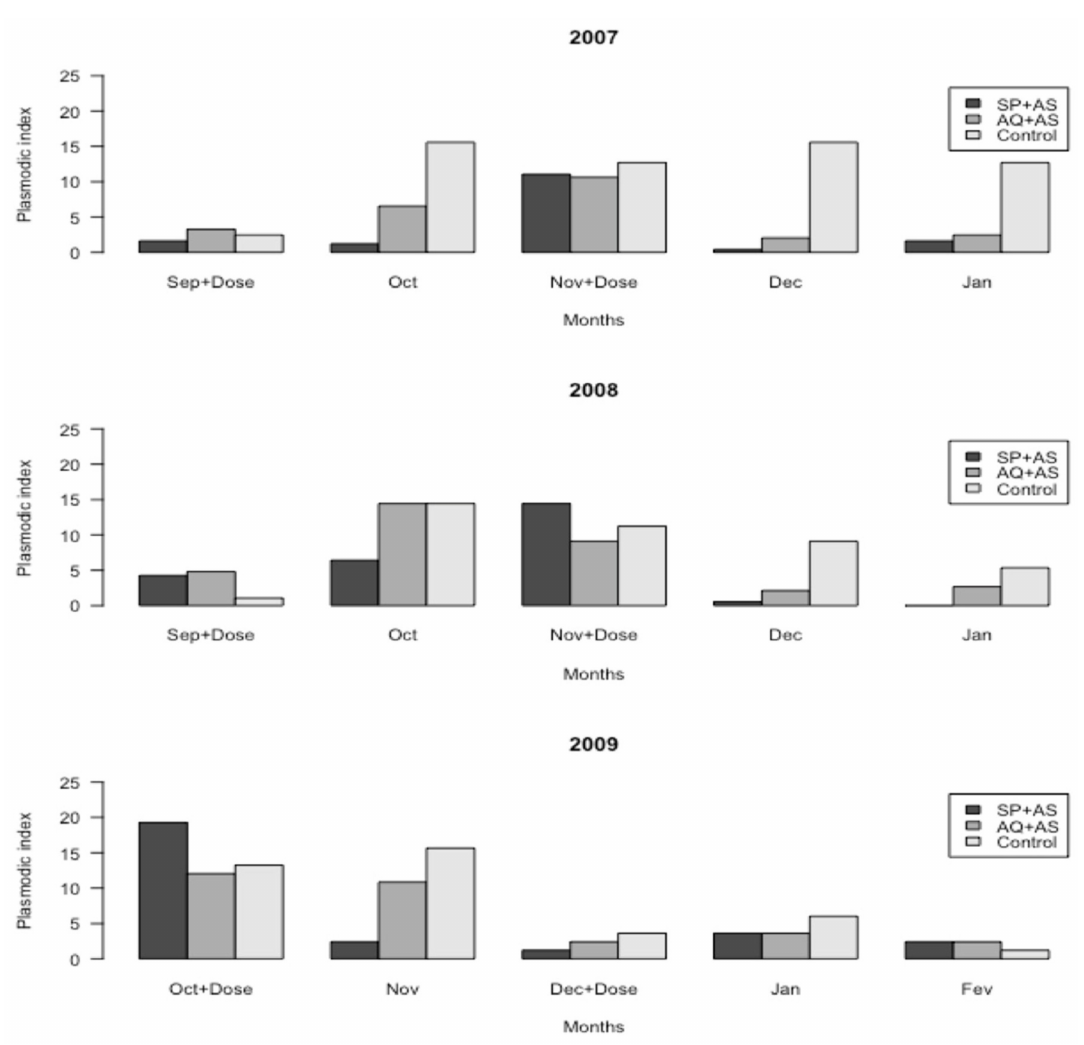
Figure 2. The prevalence of Plasmodium sp. in the treatment arms—monthly and by